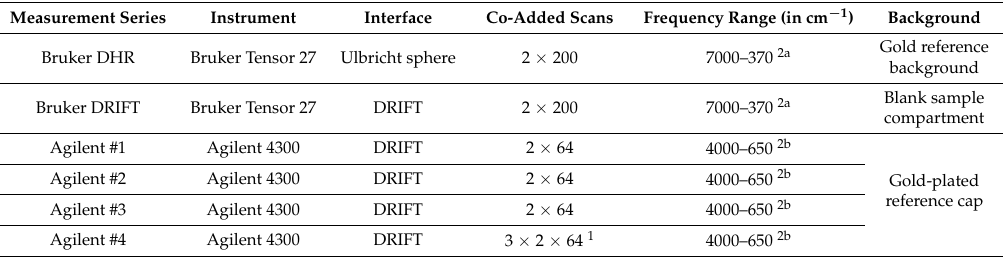
Table 2. Overview of collected MIR data and instrument